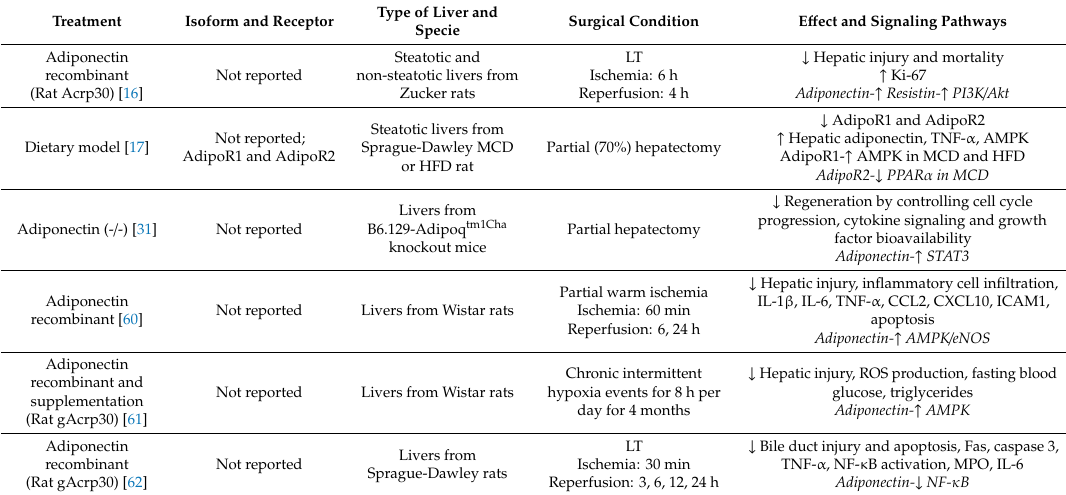
Table 1. E ff ect of strategies that regulate adiponectin action in liver surgery in studies from 2010 to 2020. Treatment Isoform and Receptor Type of Liver and Specie Surgical Condition E ff ect and Signaling